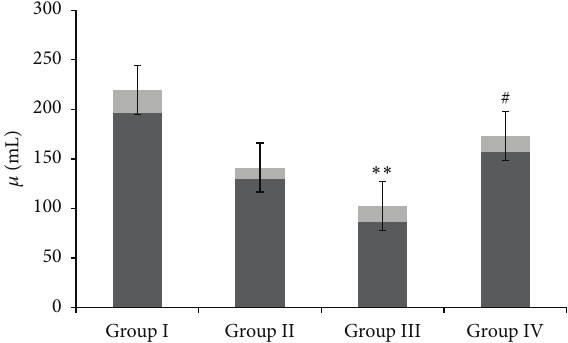
Figure 1: Effect of camel milk and gentamicin on lipid peroxidation. Effect of CM administration on GM induced renal lipid peroxida- tion. Values are expressed as mean ± SEM ( 𝑛 = 6 ). ∗∗∗ 𝑃 < 0.001 shows significant difference in group III when compared with group I. # 𝑃 < 0.05 showssignificantdifferenceingroupIVwhencompared with group III.